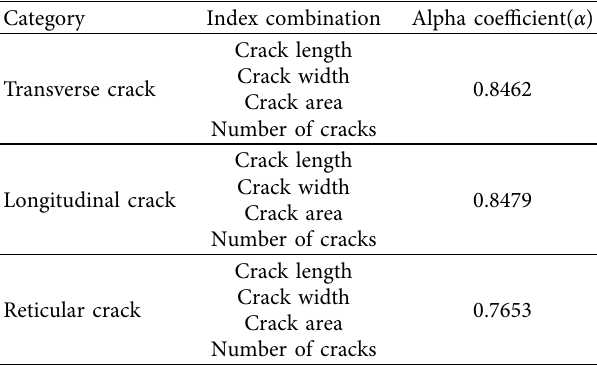
Table 2: Summary table of reliability test results.